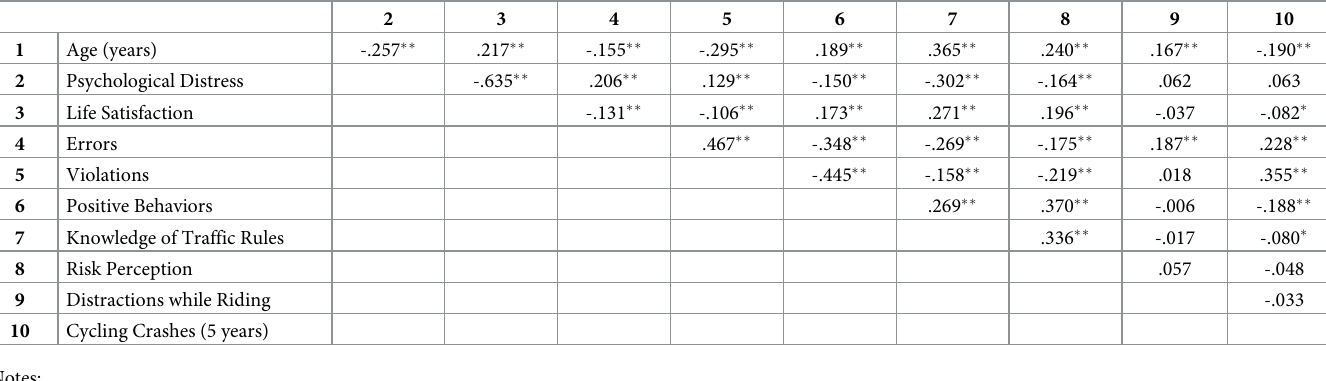
Table 2. Bivariate correlations among cycling-related variables (full sample and